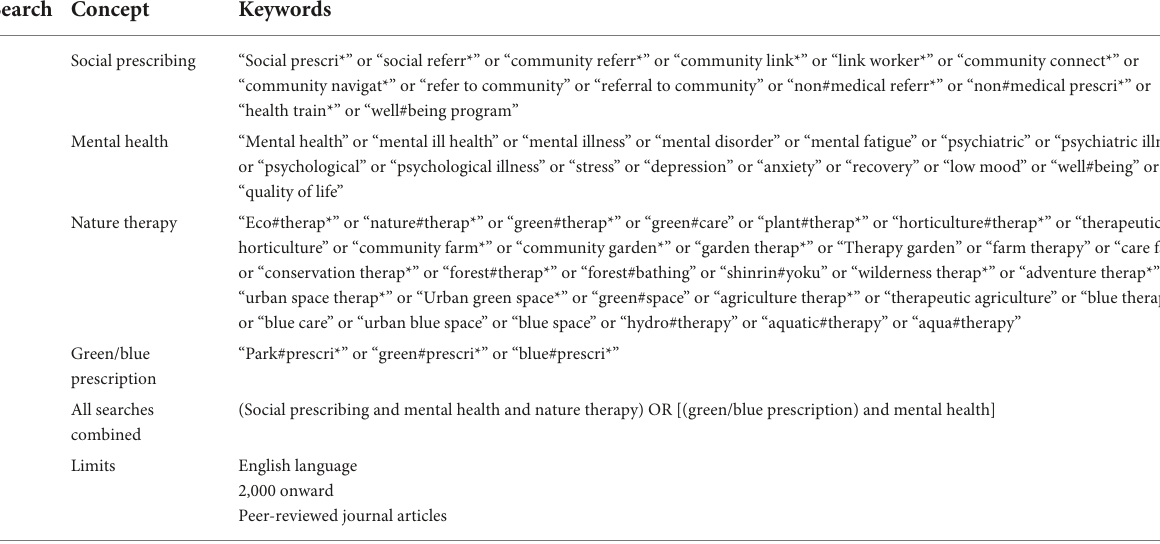
TABLE 2 Search strategy for PubMed database indicating concept search steps, combinations, and wildcards.